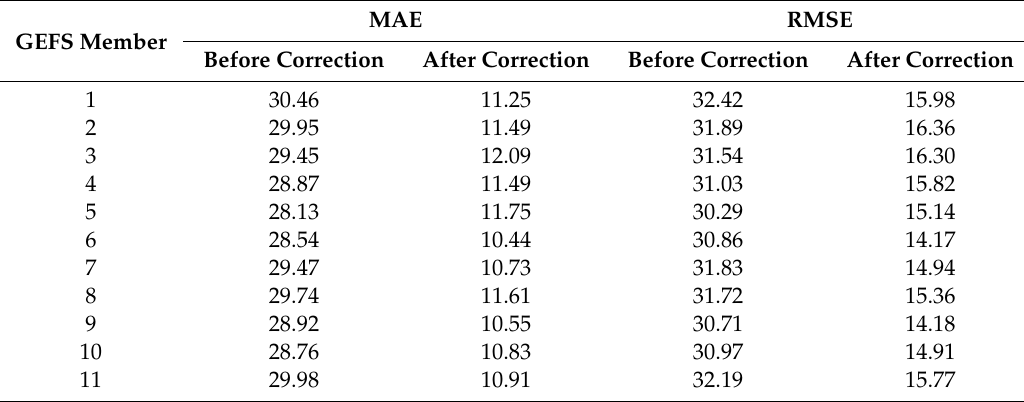
Table 1. Comparison of MAE and RMSE before and after correction. GEFS Member